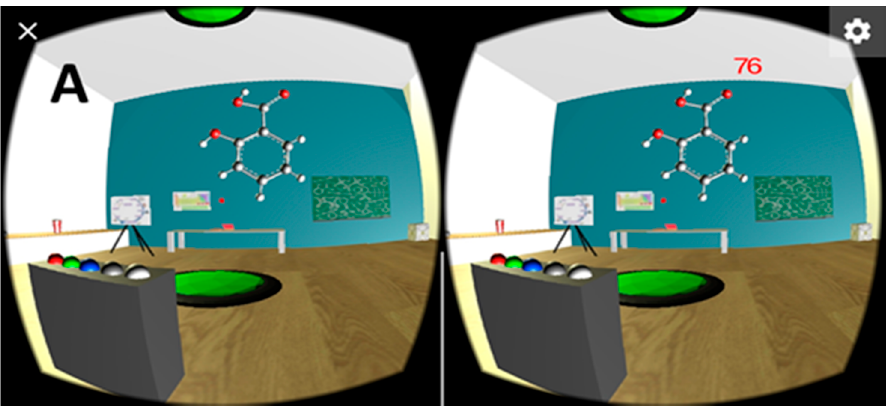
Figure 4. Screenshot of the VR application as seen in a smartphone.